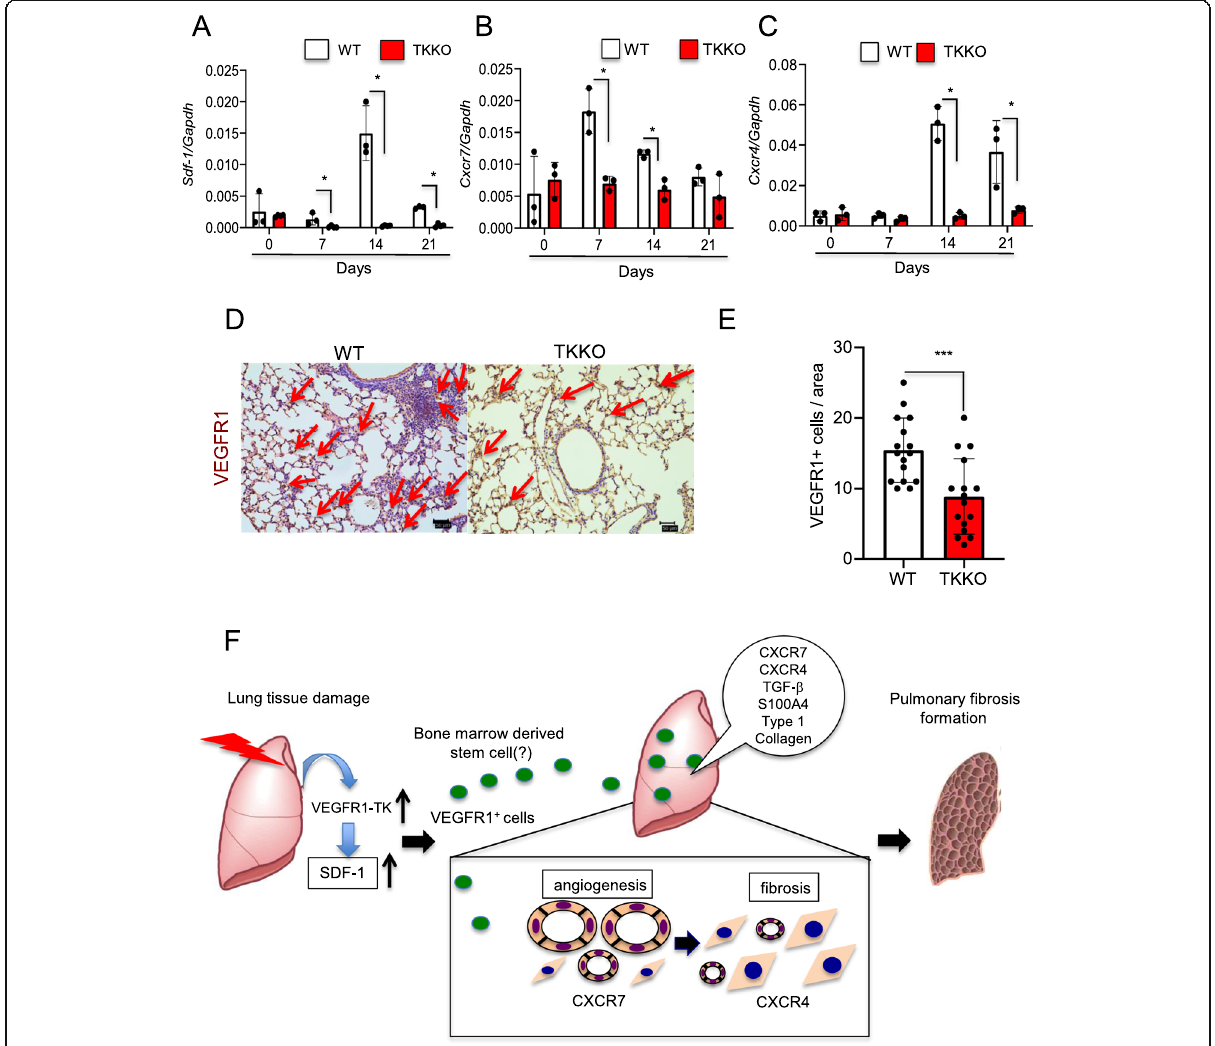
Fig. 4 VEGFR1-TK signaling induces pulmonary fibrosis by VEGFR1 + cells accumulation through the expression of SDF-1/CXCR7/CXCR4 axis. The expression of SDF-1 ( a ), CXCR7 ( b ), and CXCR4 ( c ) in the lung on days 0, 7, 14, and 21 after BLM treatment. Data are expressed as the mean ± SD (n = 3 mice per group). *p < 0.05 versus WT mice. ( c ) Representative immunohistochemical staining of VEGFR1 in the lung in WT mice and TKKO mice on day 21 after BLM treatment. Bar = 50 μ m ( d ). The number of VEGFR1 + cells in the lung WT mice and TKKO mice on day 21. Data are expressed as the mean ± SD (n = 16 mice per group). ***p < 0.001 versus WT mice. ( e ) Scheme of VEGFR1-TK signaling on pulmonary